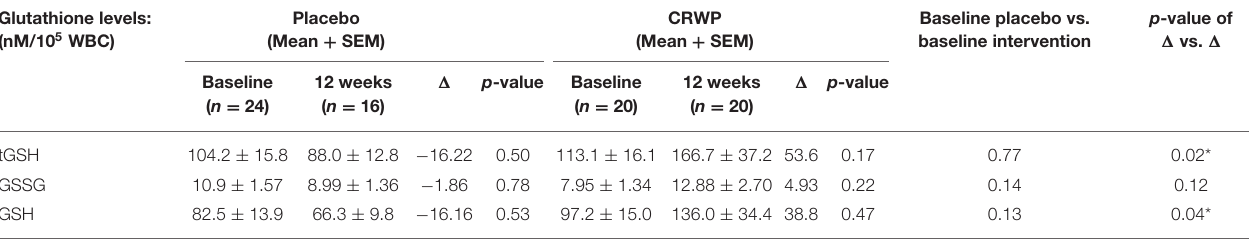
p -value of 1 vs. 1